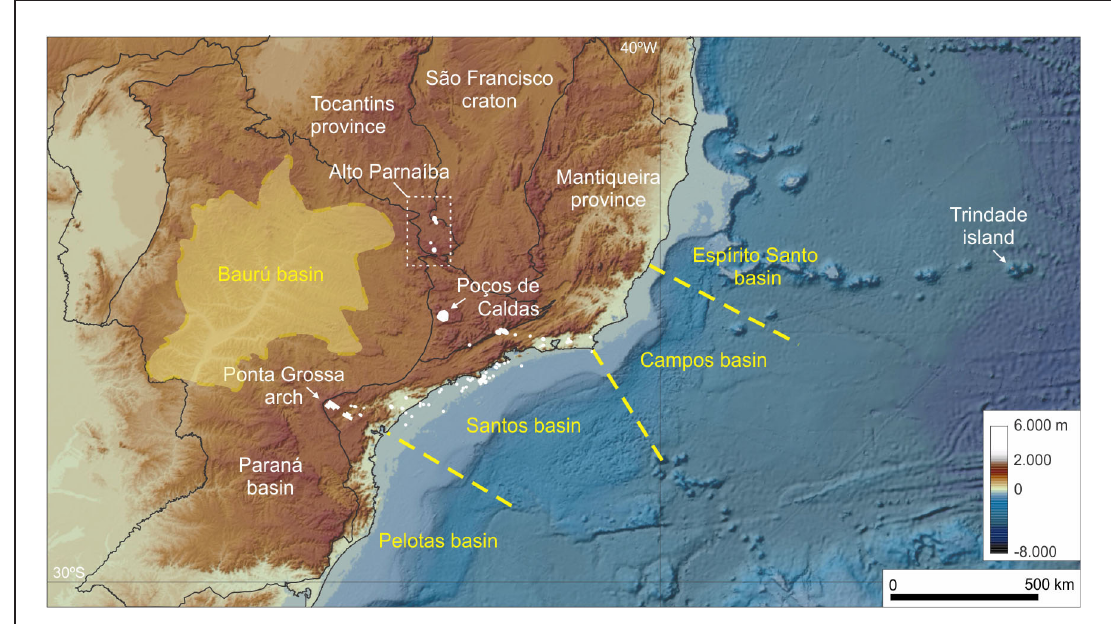
FIGURE 8 . Phanerozoic syneclises, marginal basins, and Alkaline provinces (indicated in